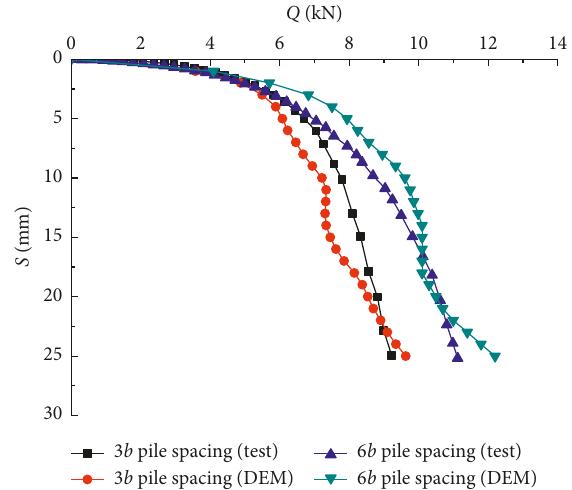
Figure 13: Comparison of numerical and experimental results.